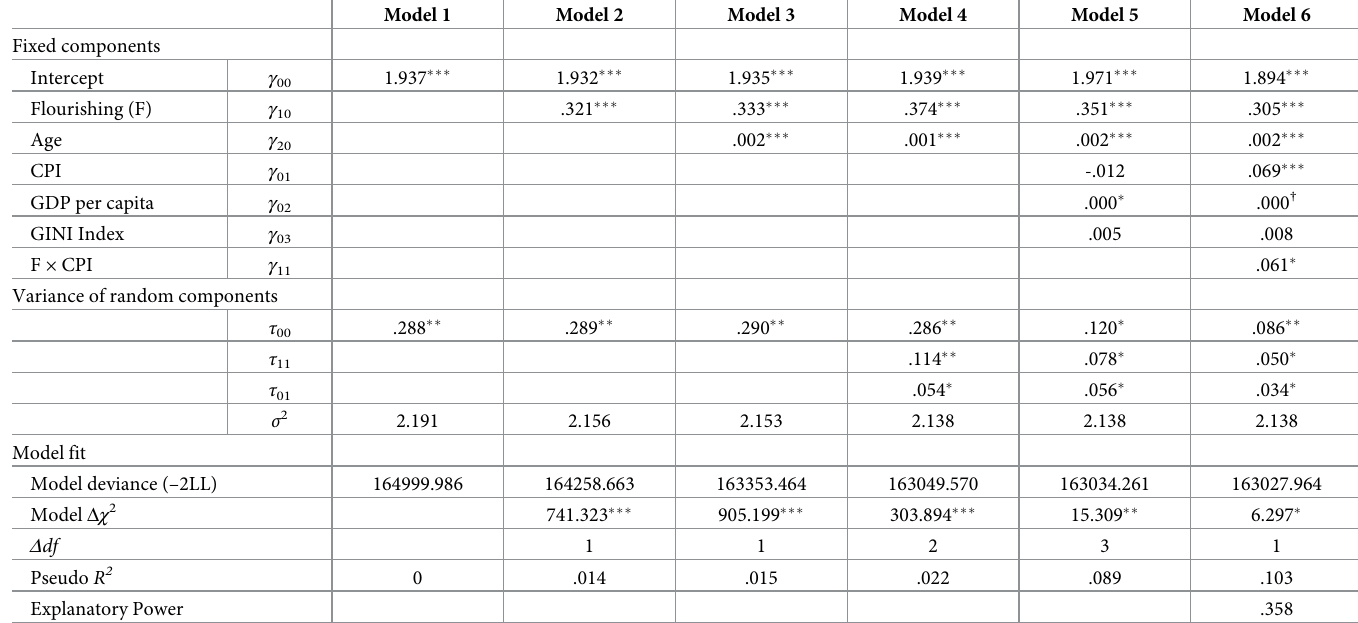
Table 2. Parameter estimates for the six models examining the relation of charitable activities on flourishing and corruption in Study